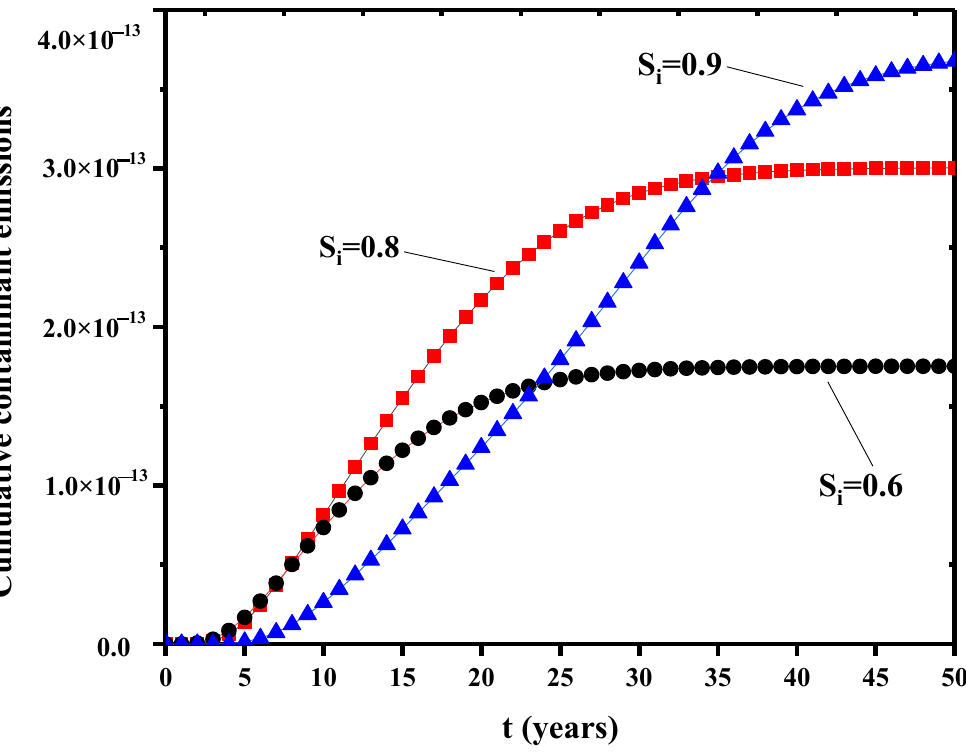
Figure 9. Change of relative permeability at the bottom under different initial saturations.